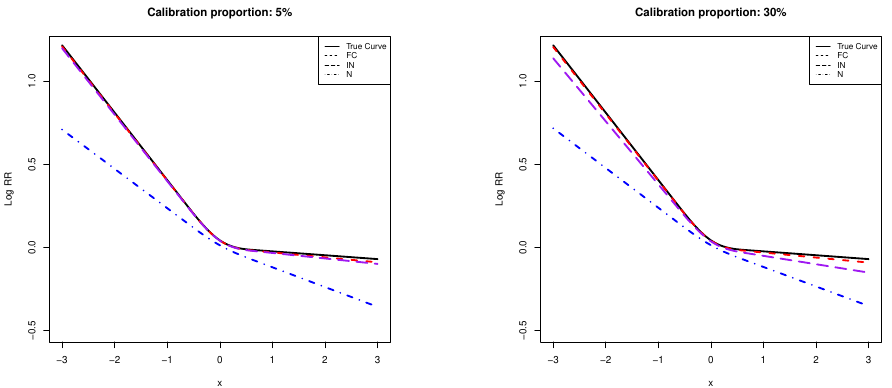
Figure 1. The average of the dose–response curves over 1000 simulations. X-axis is the biomarker measurement, and y-axis is the log RR of the disease. The solid line is the true curve, and the dotted and dashed lines were estimated using internalized (IN) and full calibration methods (FC), respectively, while the dashed-dotted line is estimated using the naive method (N). The calibration proportion is 5% (left) and 30% (right), and the coefficients of the spline functions are set to be − log ( 1.5 ) ≈ − 0.41 and 0.14,